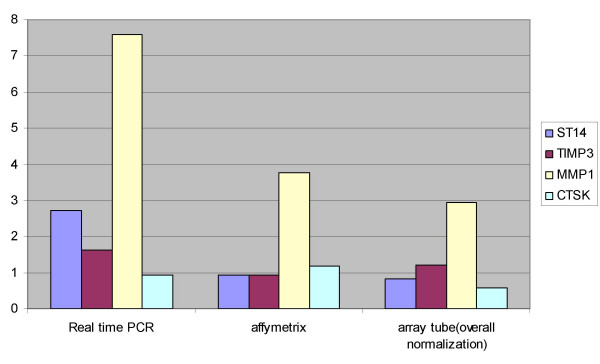
Change of the expression levels of 4 genes in Coga cells after stimulation with IL-6 analysed by three different methods. Four expressed genes as determined on the Affymetrix chip, the array tube and by quantitative RT-PCR were considered. The ratio values (non stimulated vs. IL-6 stimulated Coga cells) are indicated. (The ratio Coga/Coga + IL-6 results in high values for down regulated genes after treatment with IL-6).